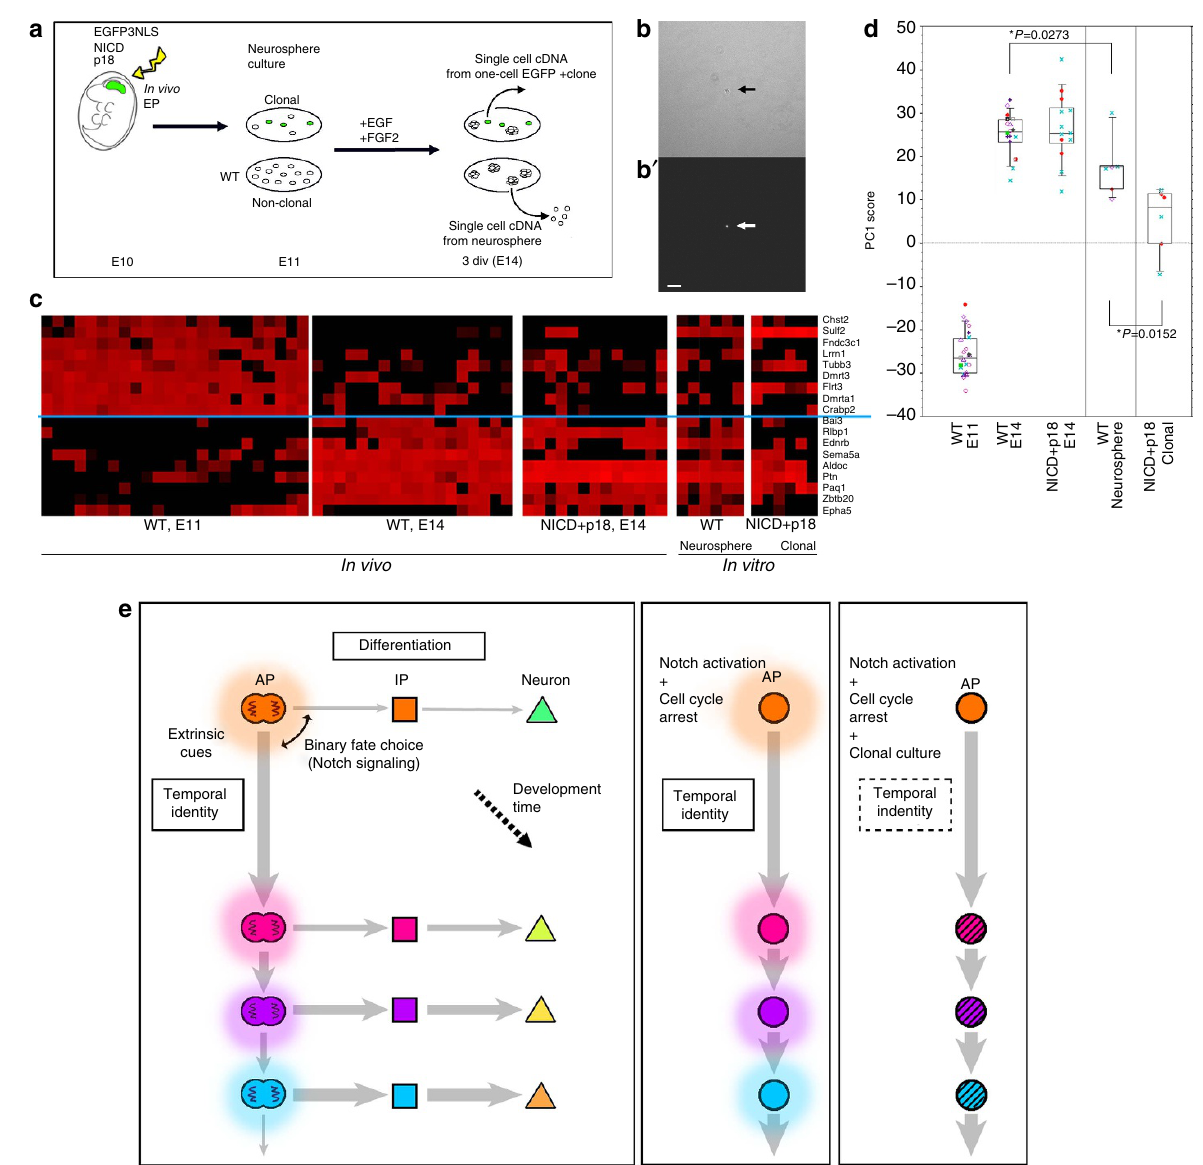
Figure 7 | Temporal change of gene expression in APs is partly cell autonomous. ( a ) Experimental design. ( b ) Single EGFP þ cell (arrow) formed one-cell clone at 3 div in clonal culture. b, Bright field; b 0 , EGFP fluorescence. Scale bar, 50 m m. ( c ) Expression levels of 18 temporal-axis genes in single APs examined by qPCR. Levels range from high (red) to low/undetectable (black) in these heat maps. Each column indicates a single AP ( N ¼ 24, wild-type E11 APs; N ¼ 18, wild-type E14 APs; N ¼ 13, E14 APs electroporated with NICD/p18 at E11 (identical to the data shown in Fig. 4); N ¼ 6, APs from